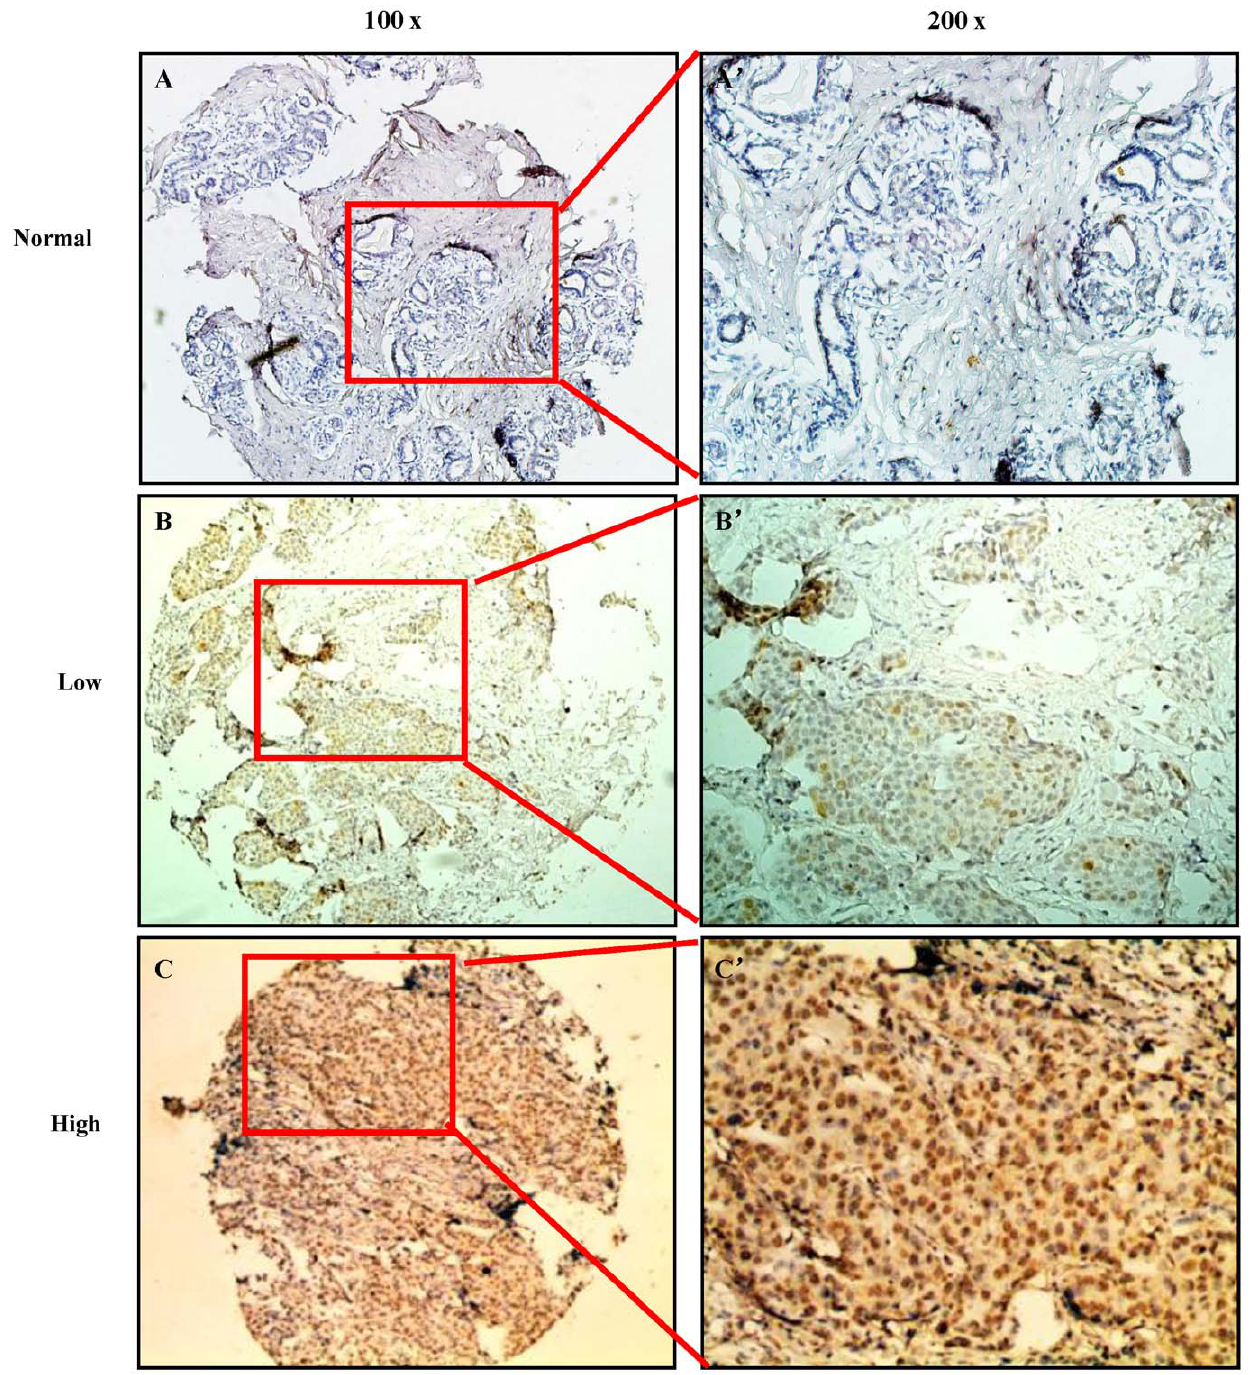
Figure 1. Immunohistochemistry analysis of Aur-A expression in normal and TNBC tissues. (A) Normal breast tissue showed nearly negative expression of Aur-A (100 6 ). (B) Low expression of Aur-A was shown in a TNBC patient sample (100 6 ). (C) Overexpression of Aur-A was detected in another TNBC case (100 6 ). (A ’), (B ’), (C ’) demonstrated the higher magnification (200 6 ) from the area of the box in (A), (B), (C), respectively.